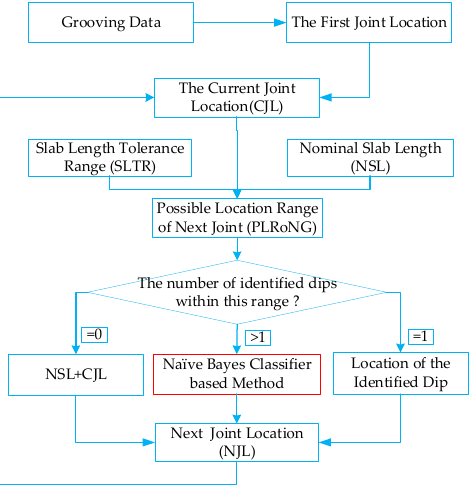
Figure 8. Diagram to separate out slab joints from the identified dips with the modified heuristic method.